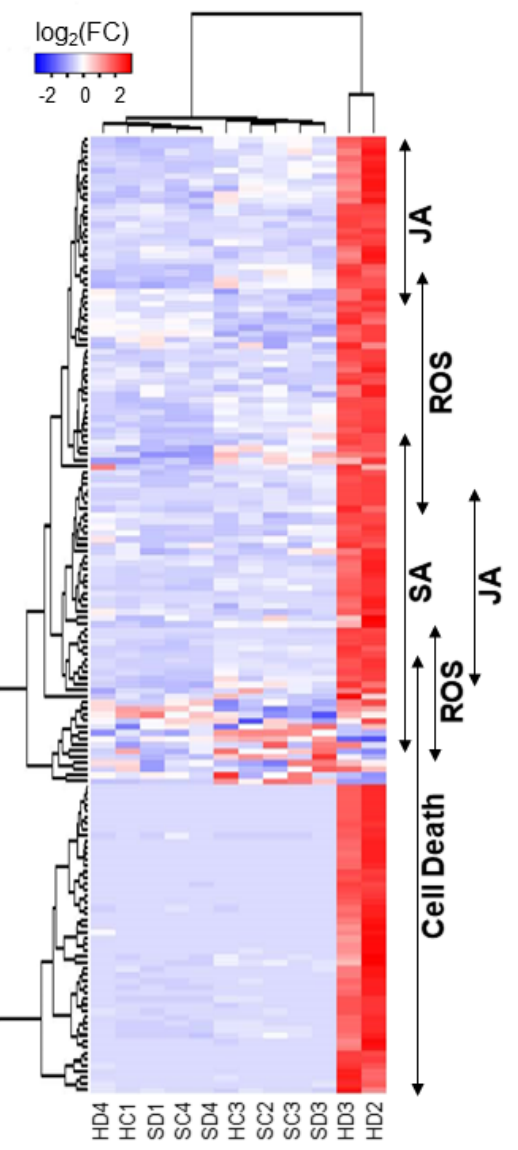
Figure 4. Hierarchical clustering of upregulated DEGs with selected annotations. The genes annotated with GO terms “response to SA” (GO:0009751), “response to JA” (GO:0009753), “response to oxidative stress” (GO:0006979), and “cell death” (GO:0008219) were selected (Supplementary Table S9), and their relative normalized count data were used to draw a heatmap. Each column represents a sample, and each row represents a selected gene. Di ff erences in expression are shown in di ff erent colors, where red and blue represent up- and downregulated expression,